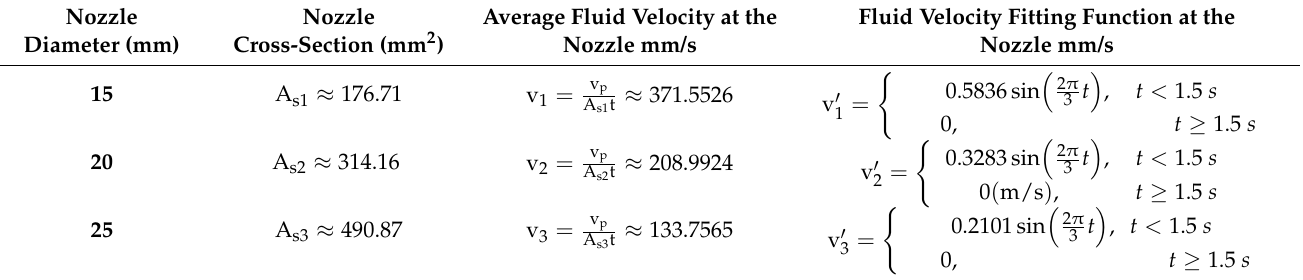
Table 1. Fluid velocity fitting at the nozzle with different nozzle diameters.